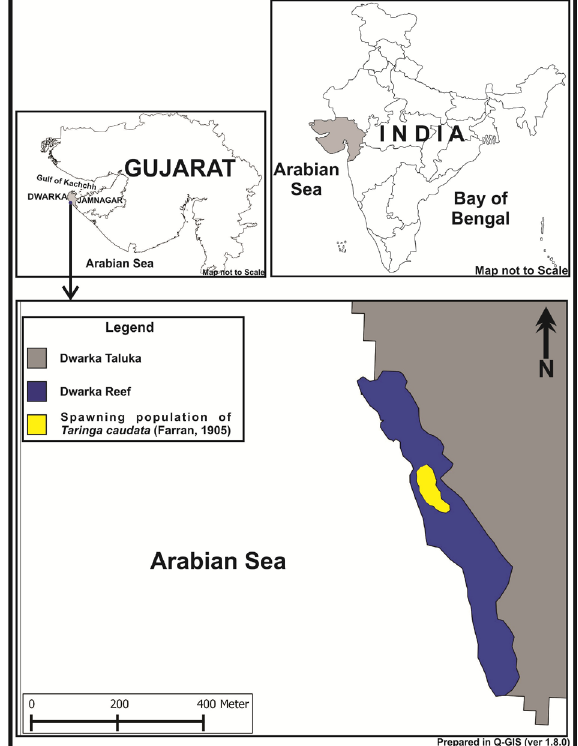
Image 2. Taringa caudata A -Adult specimen with greenish-blue egg case; B - Juvenile specimen showing extended foot; C - Ventral side showing foot, mantle and genital opening; D - Lamellate rhinophore; E - Oral tentacles; F -